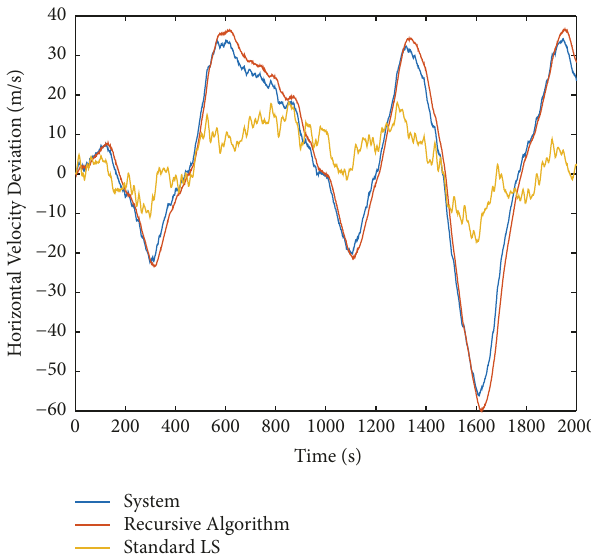
Figure 4: Comparison between identified models: horizontal veloc- ity deviation (m.s −1